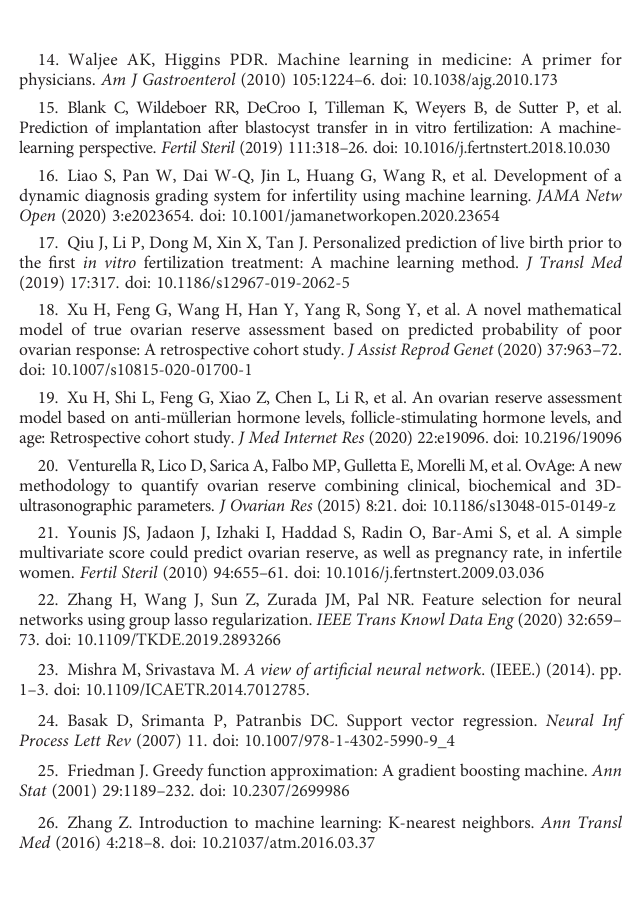
SUPPLEMENTARY FIGURE 1 Coef fi cient values for features in different steps of LASSO